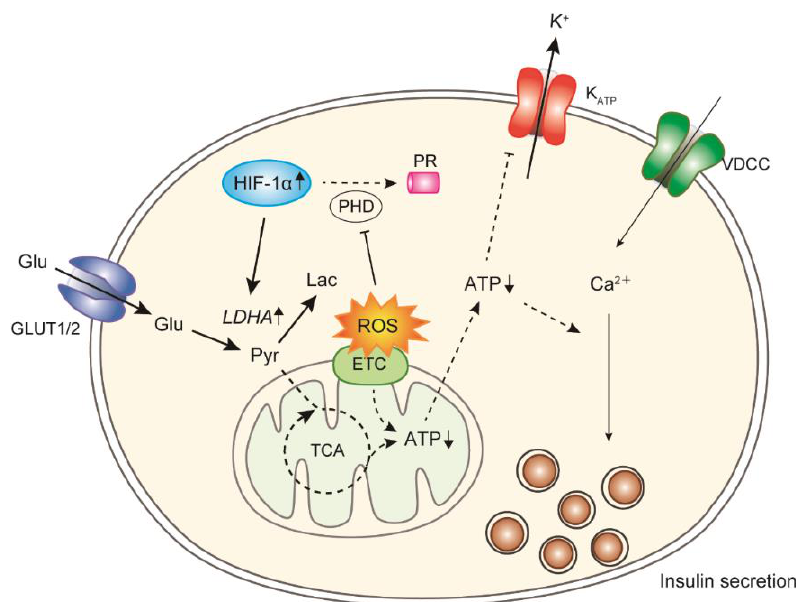
Figure 3. HIF-1 α regulates the change in glucose metabolism by ROS toxicity in diabetic β -cells. Under chronic oxidative stress, ROS inhibits PHD activity to activate HIF-1 α . LDHA activation by HIF-1 α causes excess lactate production from glucose. Glu, glucose; Pyr, pyruvate; Lac, lactate; ETC, electron transport chain; PR,